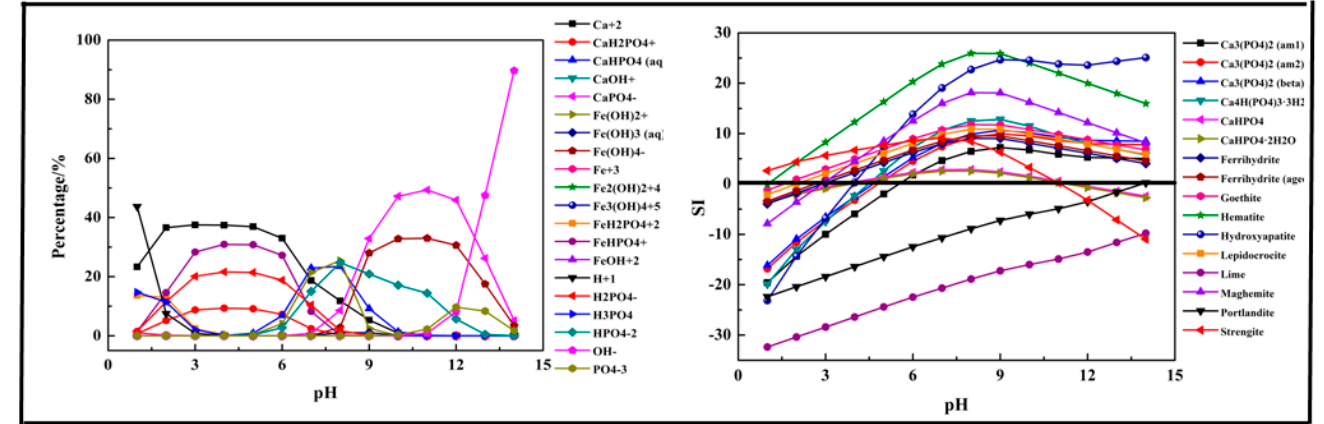
Figure 5. Percentage of species in the Fe-Ca-P-H 2 O system at 298 K at ranged pH ((P) = 0.01 mol/L, (Fe 3+ ) = 0.005 mol/L, (Ca 2+ ) = 0.0075 mol/L).